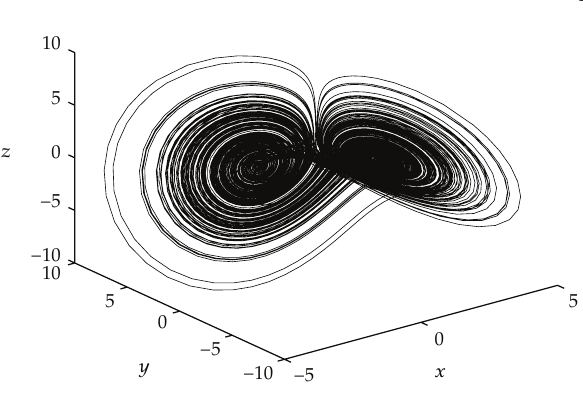
Figure 1: Strange attractor of finance system (cid:3) 1.1 (cid:4)